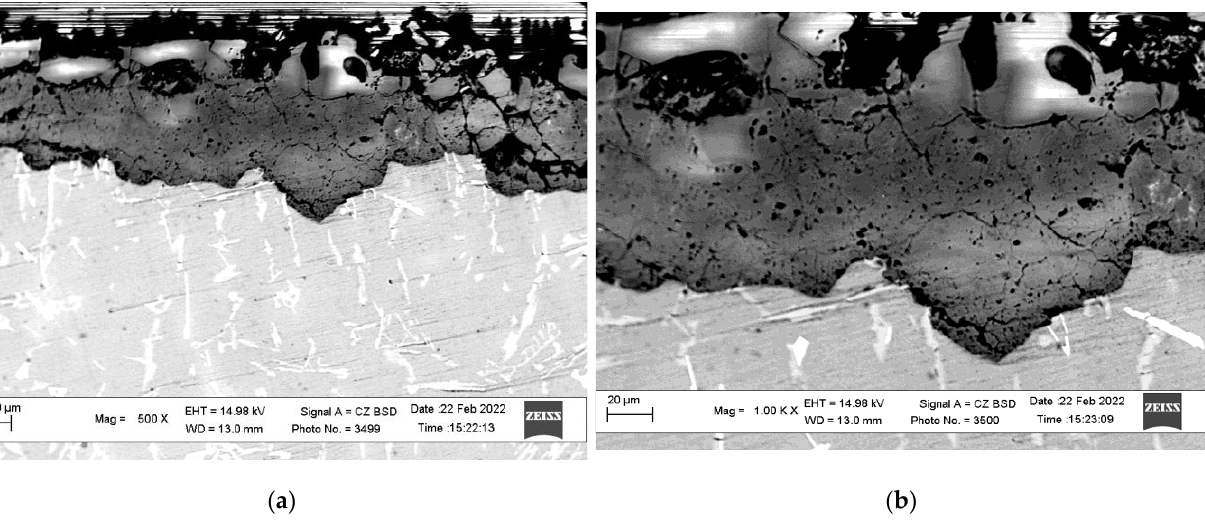
Figure 7. Structure of a PEO layer at at low ( a ) and higher ( b ) (instead different) resolutions synthe- sized in an electrolyte of 3 g/L KOH + 2 g/L Na2SiO3 + 3 g/L H2O2 on the surface of an AK9 alumi- thesized in an electrolyte of 3 g/L KOH + 2 g/L Na2SiO3 + 3 g/L H 2 O 2 on the surface of an AK9 num alloy. aluminum